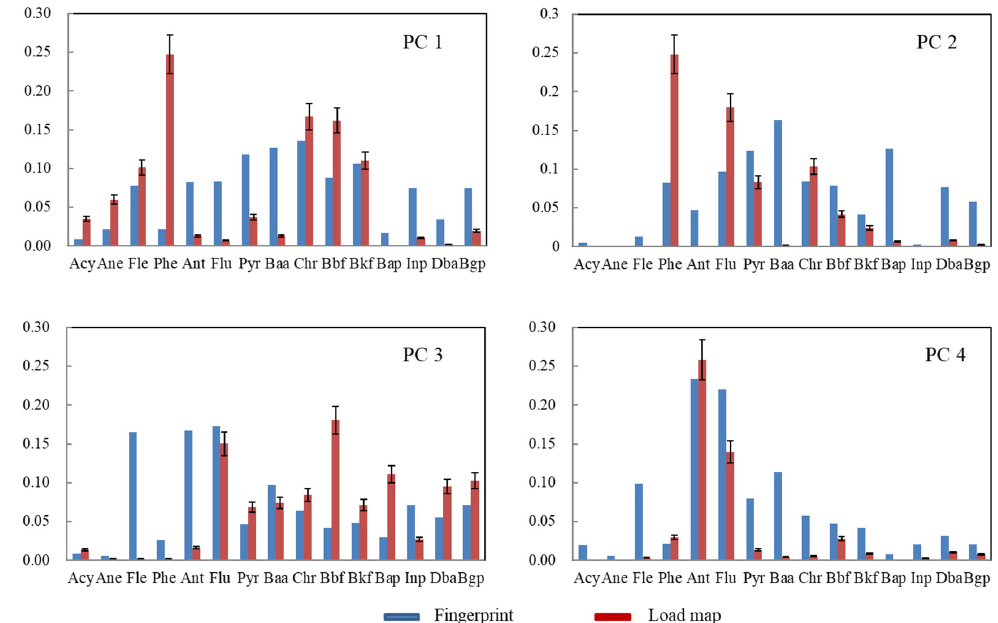
Figure 4. Source contributions derived from NMF for soil samples.